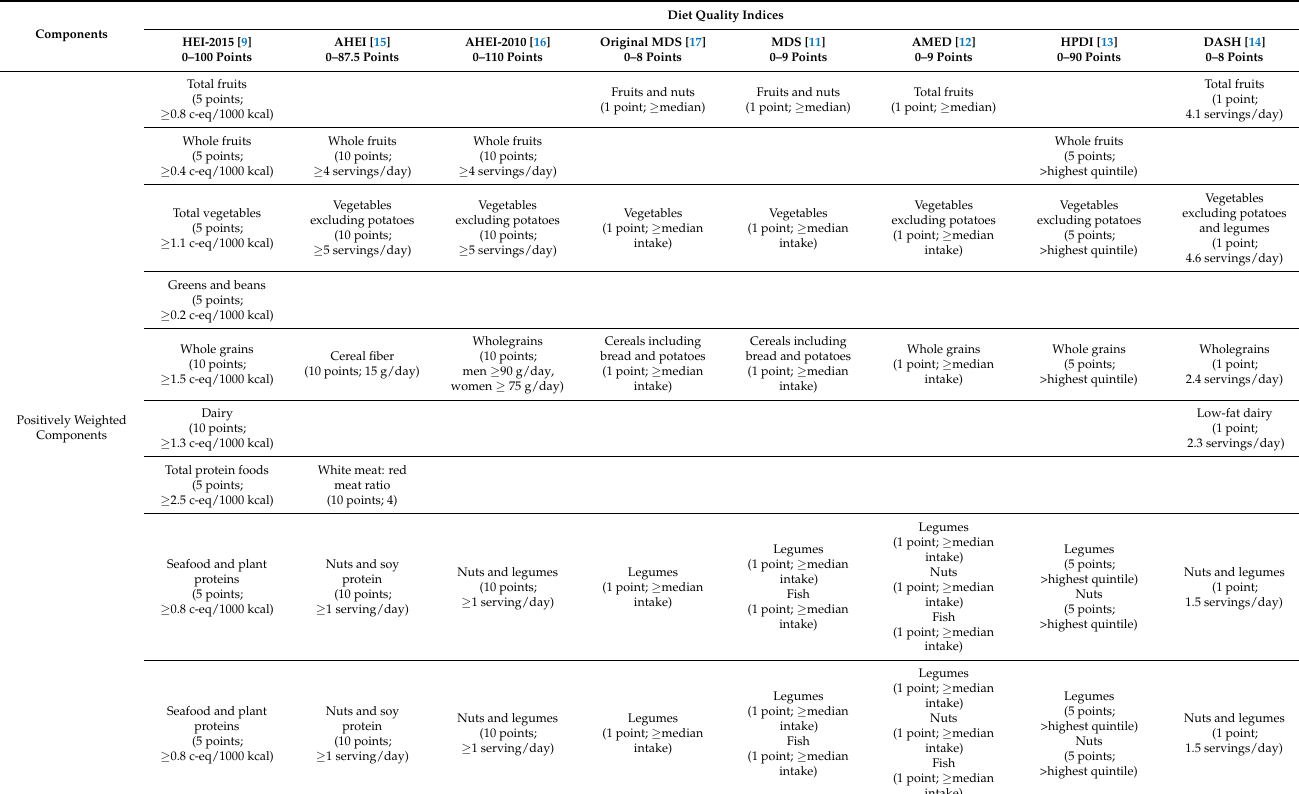
Table 1. Components and scoring criteria of commonly used diet quality indices. [9,11–17] Components